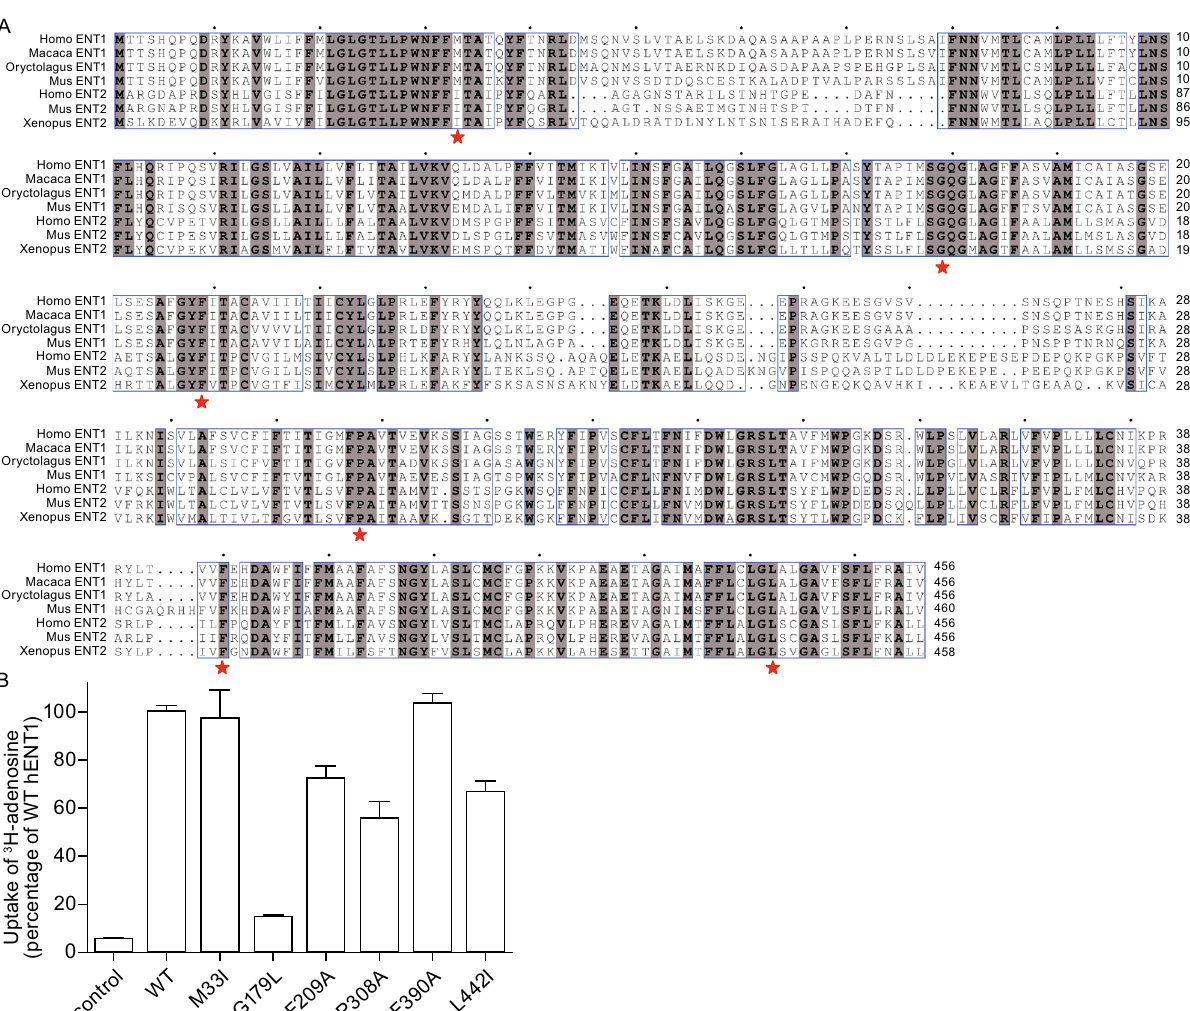
Figure 6. Effect of mutations on the transport activity of hENT1. (A) Sequence alignment among hENT1, three ENT1 orthologs from other species, hENT2, and two ENT2 orthologs from other species. Homo ENT1: Homo sapiens , GI: 118582262; Macaca ENT1: Macaca mulatta , GI: 383872534; Oryctolagus ENT1: Oryctolagus cuniculus , GI: 655841520; Mus ENT1: Mus musculus , GI: 312283707; Homo ENT2: Homo sapiens , GI: 38708299; Mus ENT2: Mus musculus , GI: 194248086; Xenolus ENT2: Xenopus tropicalis , GI: 62859387. Conserved residues are highlighted in gray. Six representative residues in panel B are indicated by red asterisks. (B) Transport activity of hENT1 variants. Six variants of hENT1 were generated and the proteins were individually puri fi ed to homogenous for transport assay. Control refers to the condition where protein-free liposomes were used. Each data point represents the average of at least three independent experiments. The error bars represent standard deviation